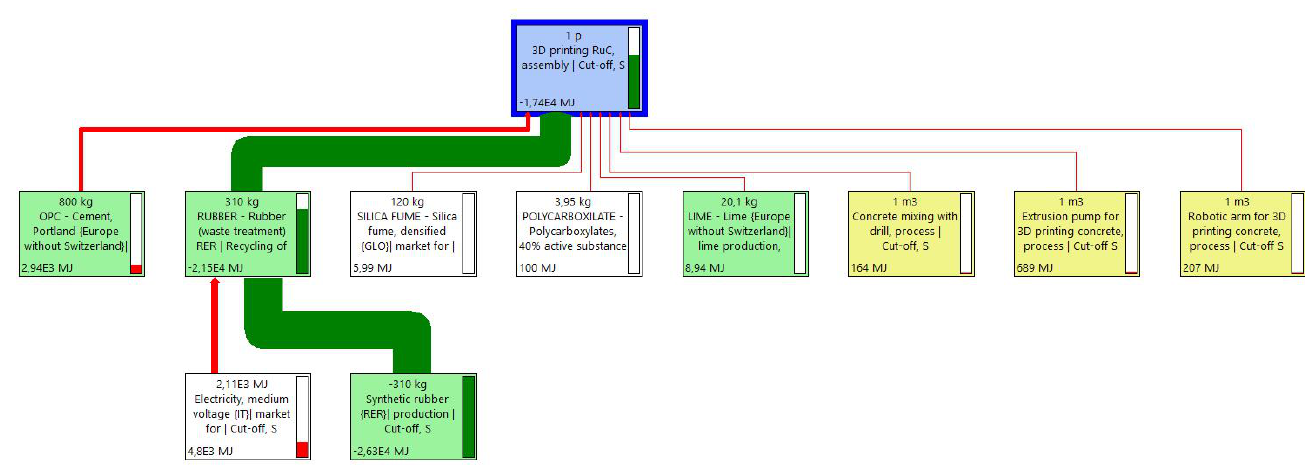
Figure A6. SimaPro CED network for c-CTR mix processing.